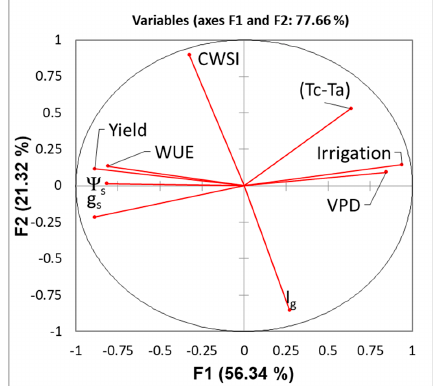
Figure 3. Principal component analysis (PCA) plot presenting variables involved in determining vine water status: remotely-sensed thermal indices (CWSI, I g , (T c -T a )), environmental conditions (VPD), vine water status (g s , Ψ s ) irrigation applied, yield, and water use efficiency (WUE) for the 2016 (S1) and 2017 (S2) growing seasons.